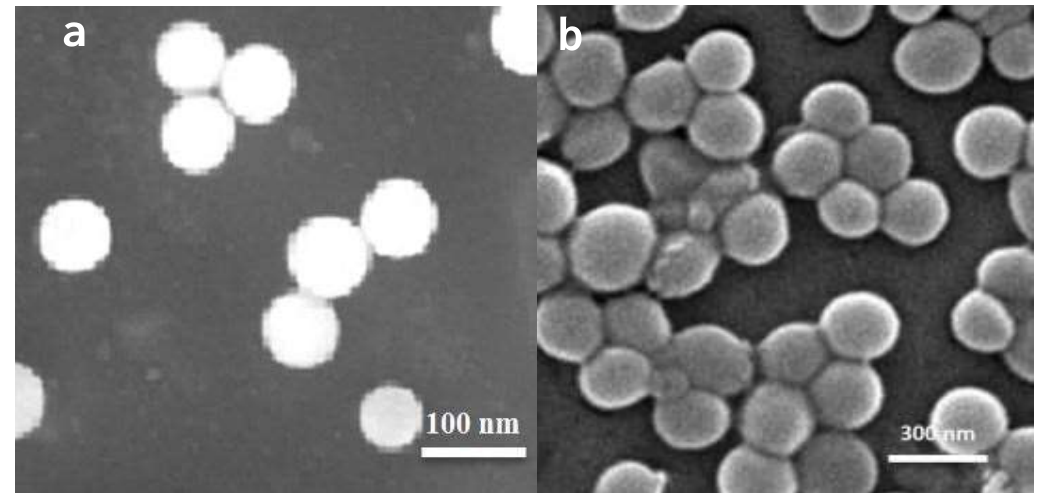
Figure 2. SEM image at laser wavelength 532 nm of (a) Fe@Au NPs, (b) FA-CU-CS-Fe@Au NPs. Figure (3) illustration micrographs TEM of nanoparticles synthesized with laser wavelength 532 nm. Figure (3) shows Fe@Au NPs core-shell which has a spherical form with around 63.65 nm nearly uniform in size. The Au NPs shell has around 31.18 nm a nearly uniform size. In figure (3) the Fe NPs core was much darker than the gold shell nanoparticles [29, 30].